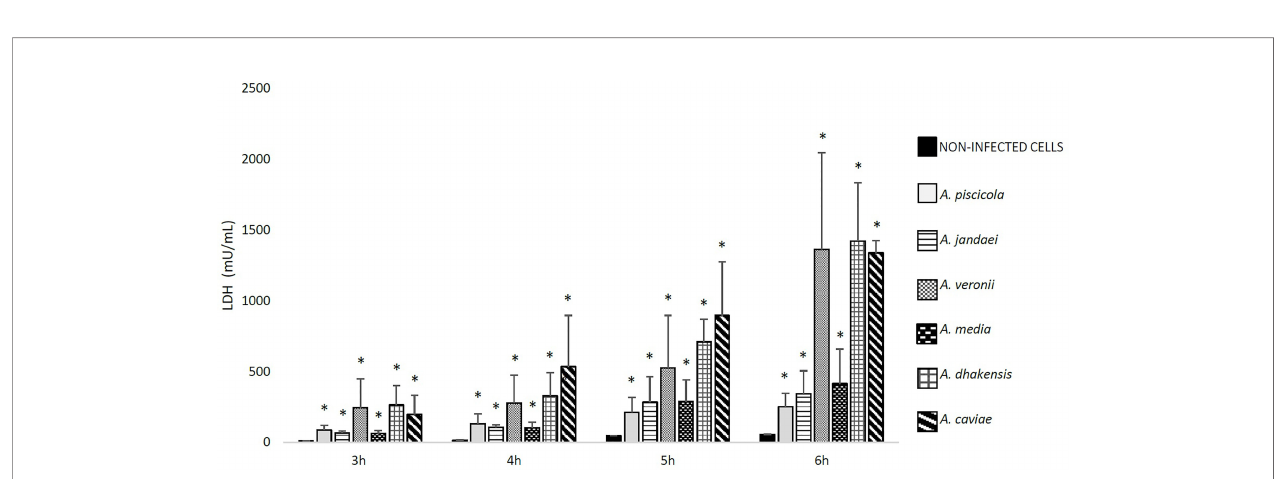
FIGURE 1 | Intracellular survival expressed as the average of the strains of each Aeromonas species after 4 h of THP-1 monocytic cell line infection at multiplicities of infection (MOI) 10 and 20. Asterisks indicate statistical signi fi cance *p